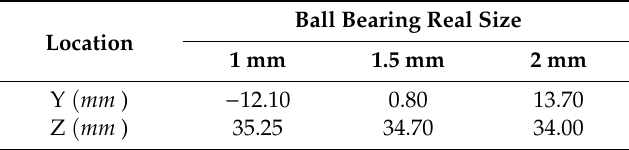
Figure 11. The current frame with the particles detected. The dashed yellow lines indicate the regions in which a particle was detected. The solid red lines represent the distance from the particles (red dots) to the top and bottom inner walls of the tube (solid green lines). Table 5. Location of the ball bearings in Figure 11.